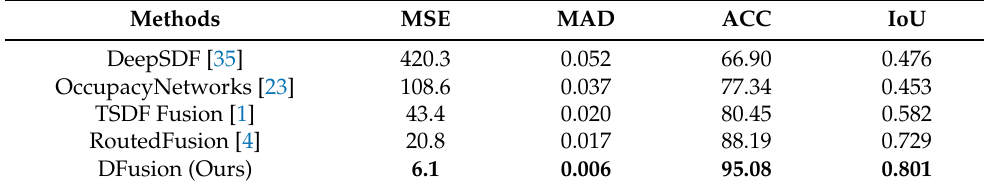
Table 2. Comparison results on ShapeNet (with depth noise and pose